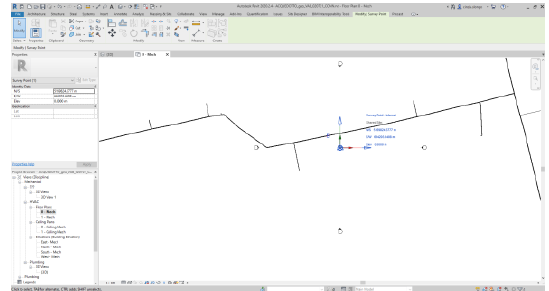
Figure 4a. Specific geographic information on X, Y, Z coordinates from Survey Point in Autodesk Revit, expressed in geometrical coordinates [m].